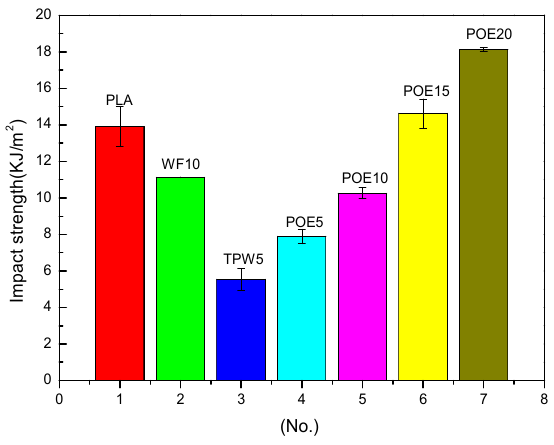
Figure 6. Impact strength of 3D printing materials.